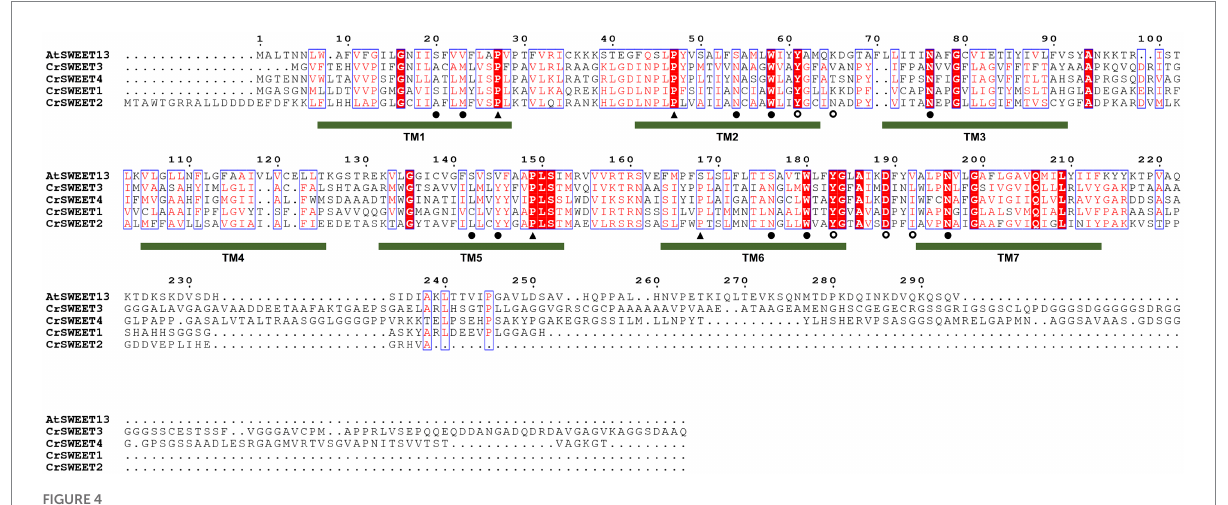
FIGURE 4 Multiple amino acid sequence alignment of AtSWEET13 compared to CrSWEET1 to 4. Amino acids that are identical or similar are in red shading or red font, respectively. Critical residues in AtSWEET13 that are required for substrate selectivity (filled circles) and transport mechanism, either as extrafacial hinge residues (open circles) or residues required for conformational change (closed triangles) are indicated with a symbol under the sequence. The position of the TM helices for AtSWEET13 is indicated and the numbering is based on the AtSWEET13